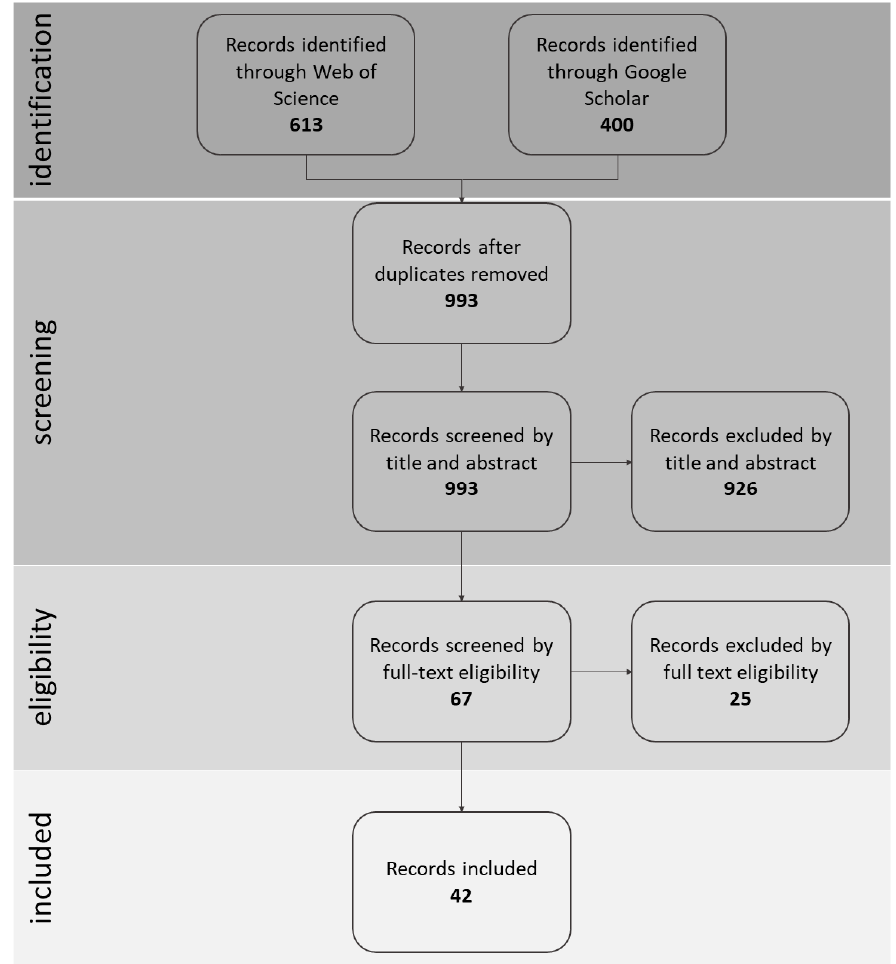
Figure 1. PRISMA inspired flow diagram.3.1. Year of publication and geographical distribution of the studies.